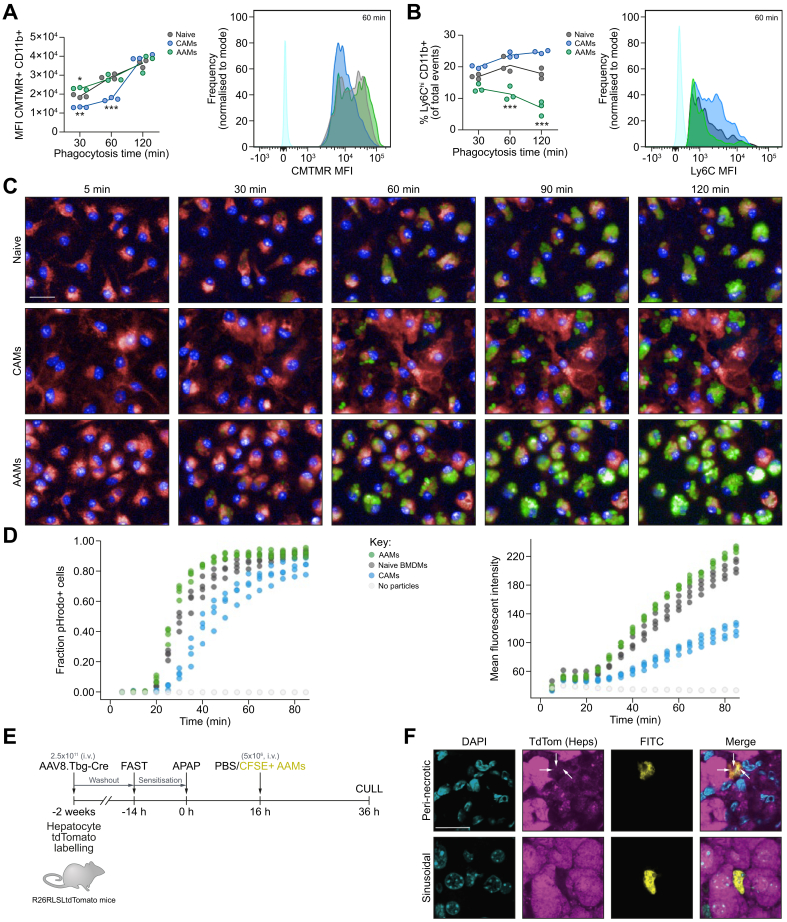
Murine AAMs are highly phagocytic.(A) Phagocytosis quantification in naïve BMDMs (dark grey), AAMs (green), or CAMs (blue) during incubation with CMTMR-labelled apoptotic thymocytes. MFI of CMTMR-positive macrophage populations (left), and representative histograms (right). (B) Ly6C status in BMDM populations during incubation with CMTMR-labelled apoptotic thymocytes at indicated times (left panel); representative histograms (right panel). Coloured circles represent individual preparations connected by lines (mean value, n = 3). (C) Representative images of real-time phagocytosis at indicated times. Naïve BMDMs (top row), CAMs (middle row) and AAMs (bottom row) are shown (Deep Red CellMask, red; NucBlue, blue). Phagocytosis indicated by intracellular fluorescence (green). (D) Phagocytosis quantification: pHrodo-positive cell fraction (left) and total cell MFI (right). (E) Study design: Hepatocytes were Tdtomato-labelled by delivery of hepatotropic AAV8 virus delivering Cre-recombinase to R26RLSLtdTomato mice. Tdtomato-positive APAP-ALI mice received CFSE-labelled AAMs (5 × 106, i.v.) at 16 h, before cull (36 h). (F) Panels show representative confocal immunofluorescence of liver tissue (max intensity projection from 7 slices; 2.4 μm) in each channel: DAPI (cyan), TdTom (TdTomato+ hepatocytes, magenta), FITC (CFSE+ AAMs, yellow), and merged images. Faint punctate TdTomato+ debris were visible inside vesicles in peri-necrotic macrophages (top row, white arrow heads). ∗p <0.05, ∗∗p <0.01, ∗∗∗p <0.001, scale bars 20 μm. Two-way ANOVA (A/B). AAMs, alternatively activated macrophages; AAV, adeno-associated virus; ALI, acute liver injury; APAP, acetaminophen; APAP-ALI, APAP-induced ALI; AST, aspartate aminotransferase; BM, bone marrow; BMDMs, bone marrow-derived macrophages; CAMs, classically activated macrophages; DAMs, deactivated macrophages; MFI, mean fluorescence intensity.